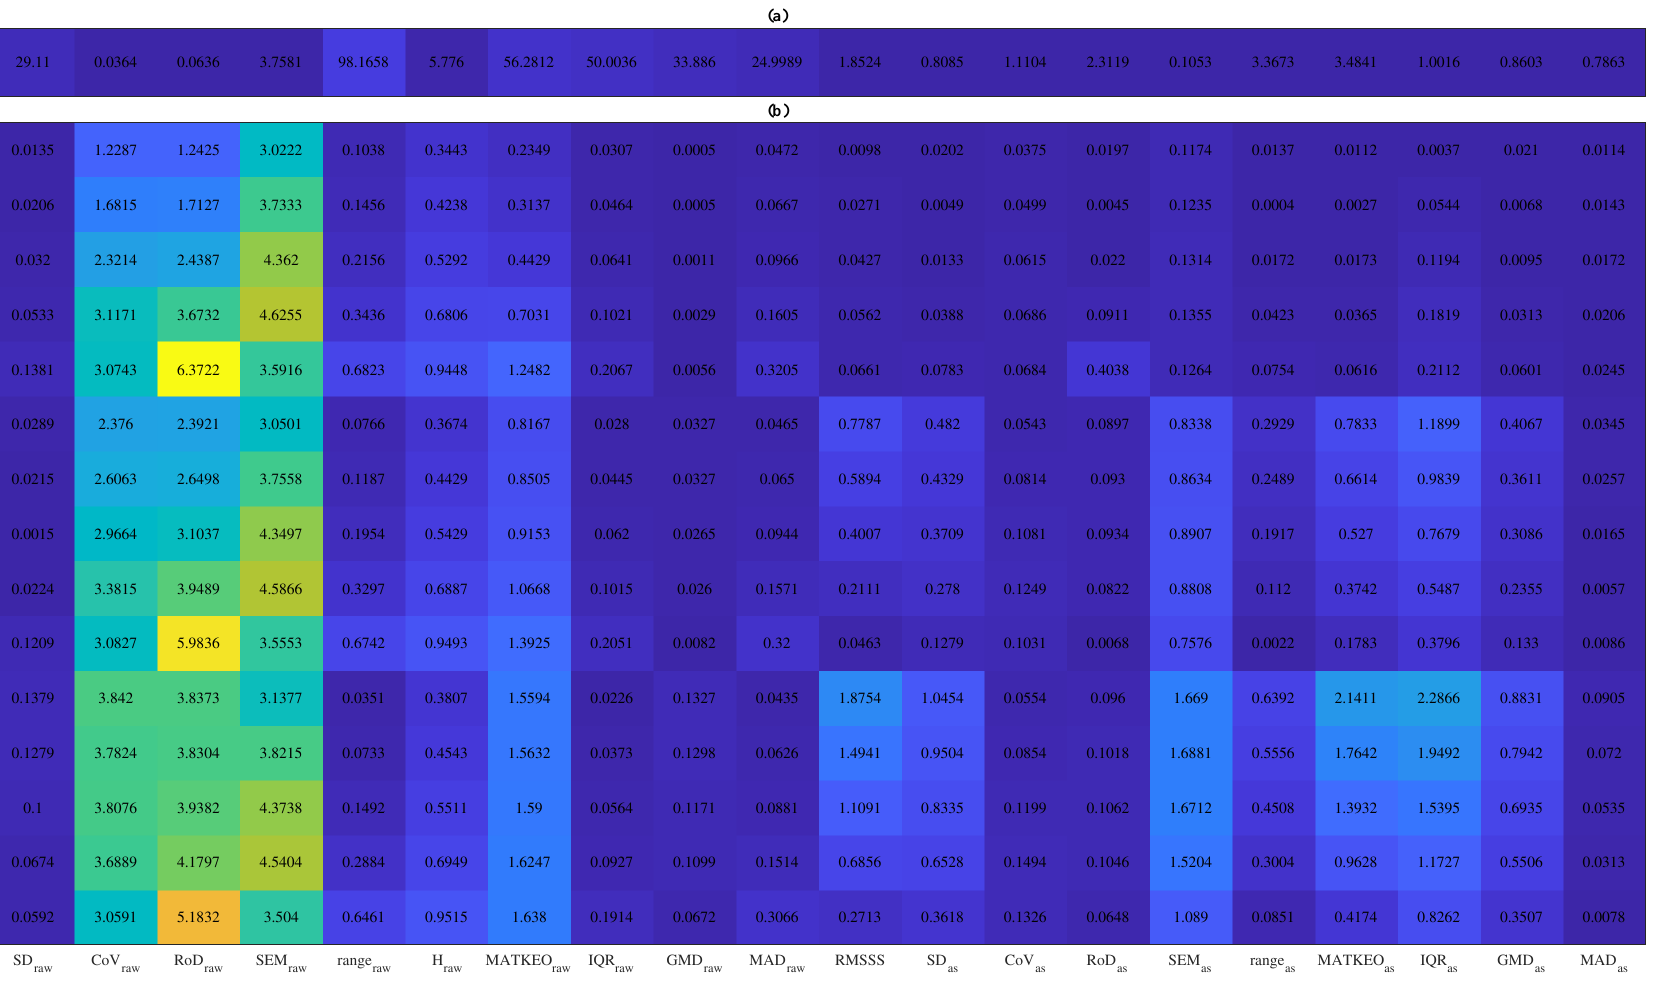
Figure 3. Results for 4000 realizations with a linear function. The meaning of all quantities can be found in the table of abbreviations. ( a ) Mean values in the favorable scenario. ( b ) Performance